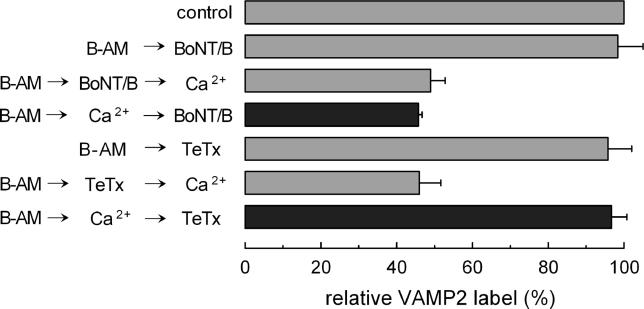
VAMP2 Is Engaged in Loose SNARE Complexes before the Efflux of Intra-Acrosomal Ca2+
Permeabilized spermatozoa were loaded with 10 μM BAPTA-AM (B-AM) for 15 min at 37 °C to chelate intra-acrosomal Ca2+. AE was then initiated by adding 10 μM free Ca2+ (Ca2+). After 15 min incubation at 37 °C to allow exocytosis to proceed to the intra-acrosomal Ca2+-sensitive step, 100 nM neurotoxins recognizing VAMP (BoNT/B or TeTx) were added to the tubes and the samples were incubated for 15 min at 37 °C (B-AM→Ca2+→neurotoxin, black bars). Samples were then immunolabeled with an anti-VAMP2 antibody as described in Materials and Methods. Notice that at this stage VAMP2 immunolabeling was sensitive to BoNT/B but not to TeTx. Several other conditions are included (grey bars). The toxins did not affect VAMP2 staining in resting sperm (compare control versus B-AM→neurotoxin). However, the toxins decreased the VAMP2 labeling when present during stimulation (B-AM→neurotoxin→Ca2+). Fluorescence was normalized as described in Materials and Methods (mean ± SEM). Statistical analysis is provided in Table S8.